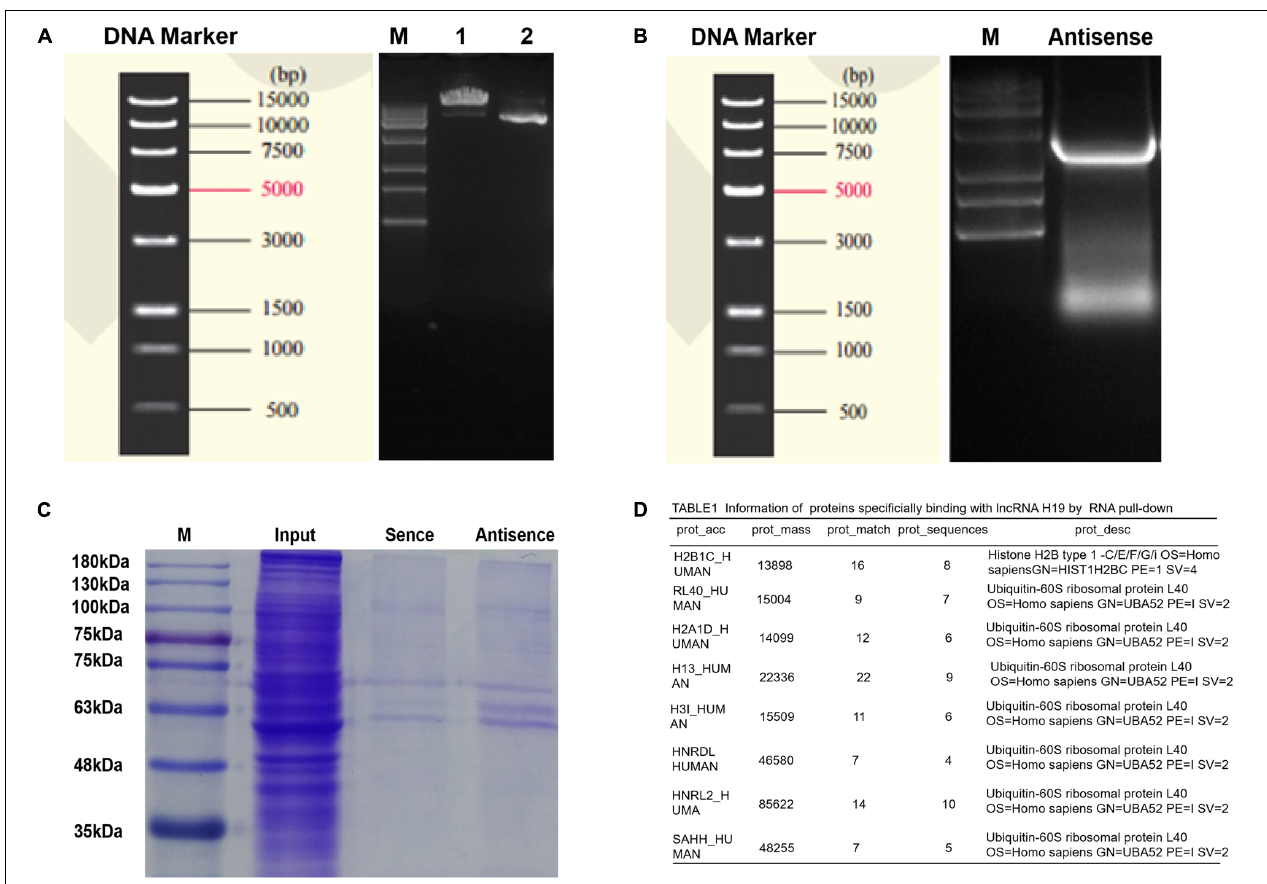
FIGURE 6 | Determinations of proteins bound to lncRNA H19 by biotin-labeled RNA pull-down and mass spectrometry analysis in DP cells. (A) The results of plasmid linear enzyme digestion electrophoresis. (B) Electrophoretic results of H19 antisense PCR products. (C) Results of polyacrylamide gel electrophoresis (staining by Coomassie brilliant blue). (D) Information of proteins binding with lncRNA